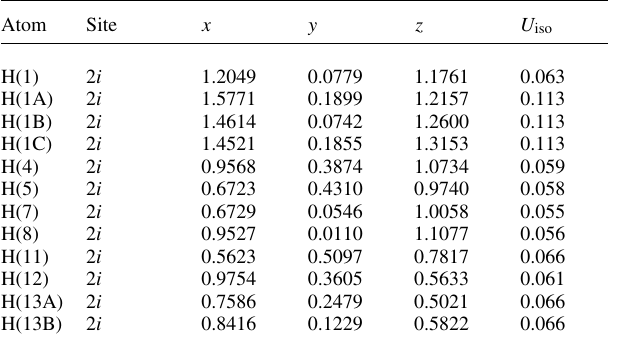
Table 2. Atomic coordinates and displacement parameters (in Å 2 )